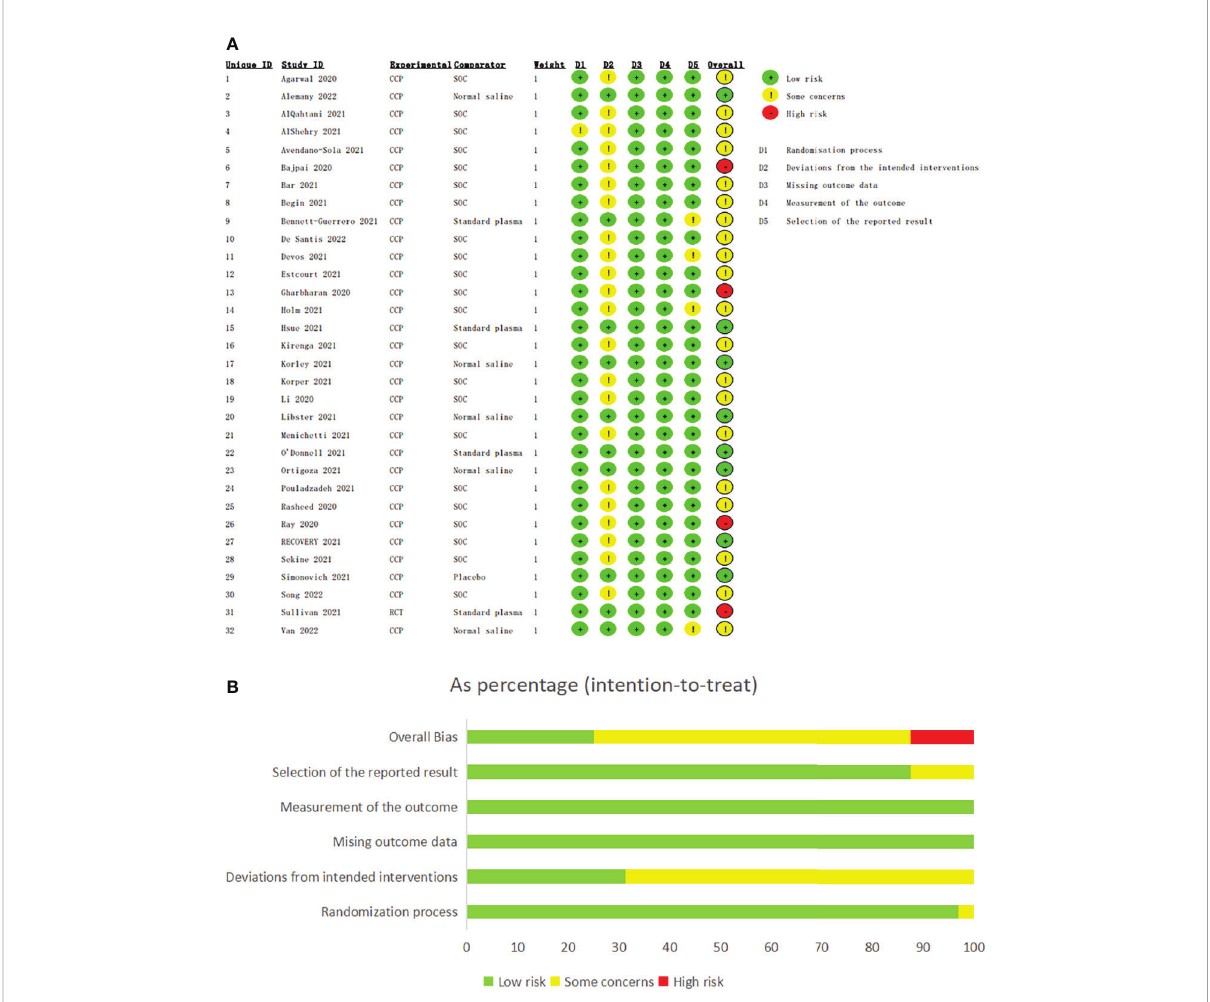
FIGURE 2 The assessments of risk of bias of eligible studies. The assessments of risk of bias of eligible studies. (A) The assessment of each eligible study. (B) The assessment of overall bias. Bajpai 2020, Gharbharan 2020, Ray 2020 and Sullivan 2021 were classi fi ed as high risk for pre-printed and lack of peer review although no high risks of bias in